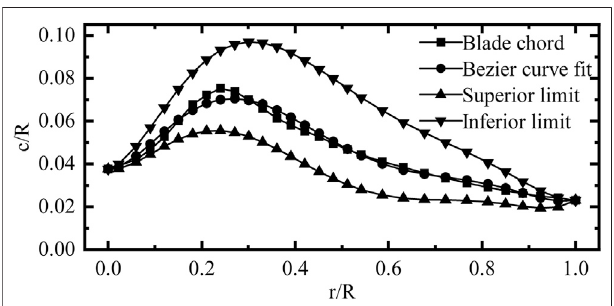
FIGURE 1 | The chord distribution